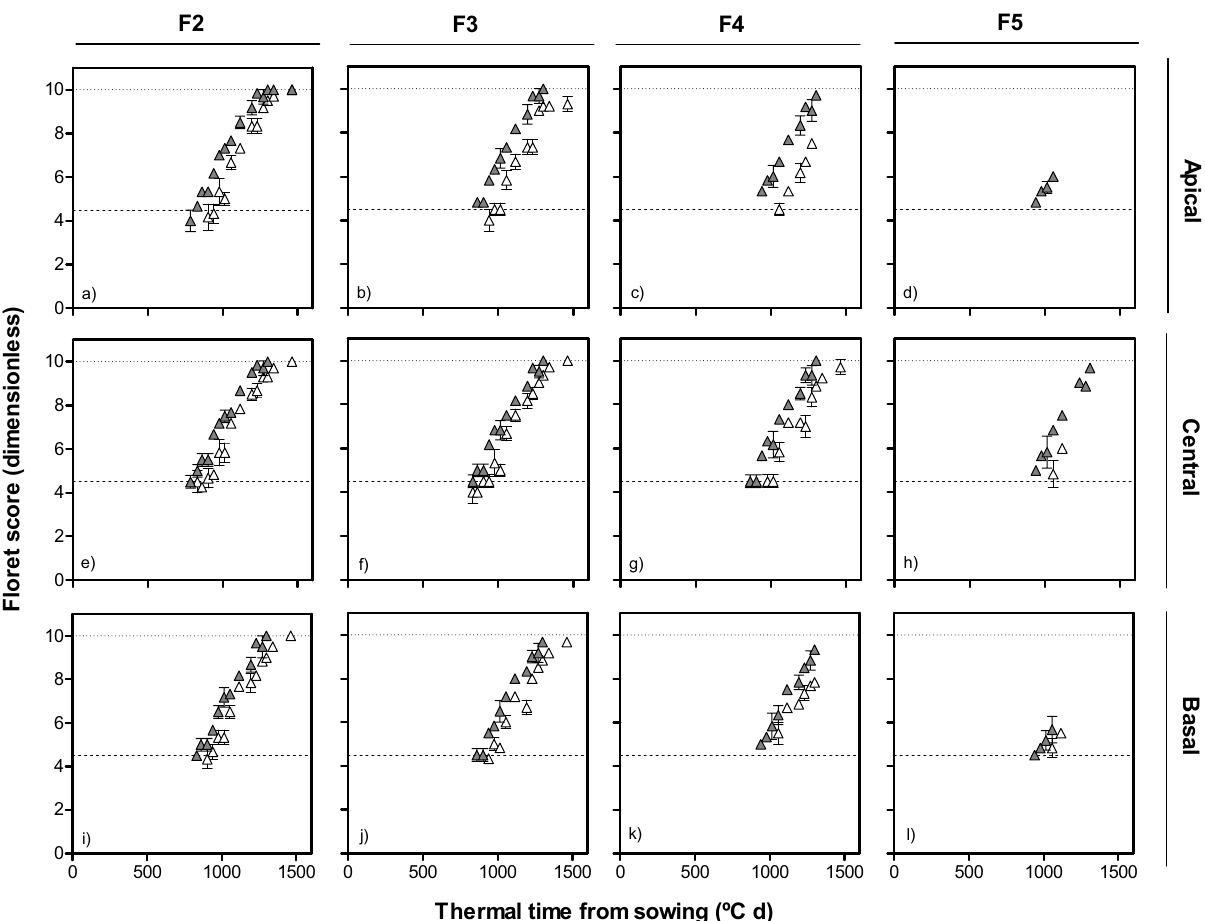
Figure 5. Dynamics of floret development (floret score) in F2, F3, F4 and F5 florets at apical (top panels: a – d ), central (middle panels: e – h ) and basal (bottom panels: i – l ) positions of the spike with thermal time from sowing in lines with Eps-7D-late (open symbol) and - early (closed symbol) allele with Eps-2B-late allele in the background in the first cropping